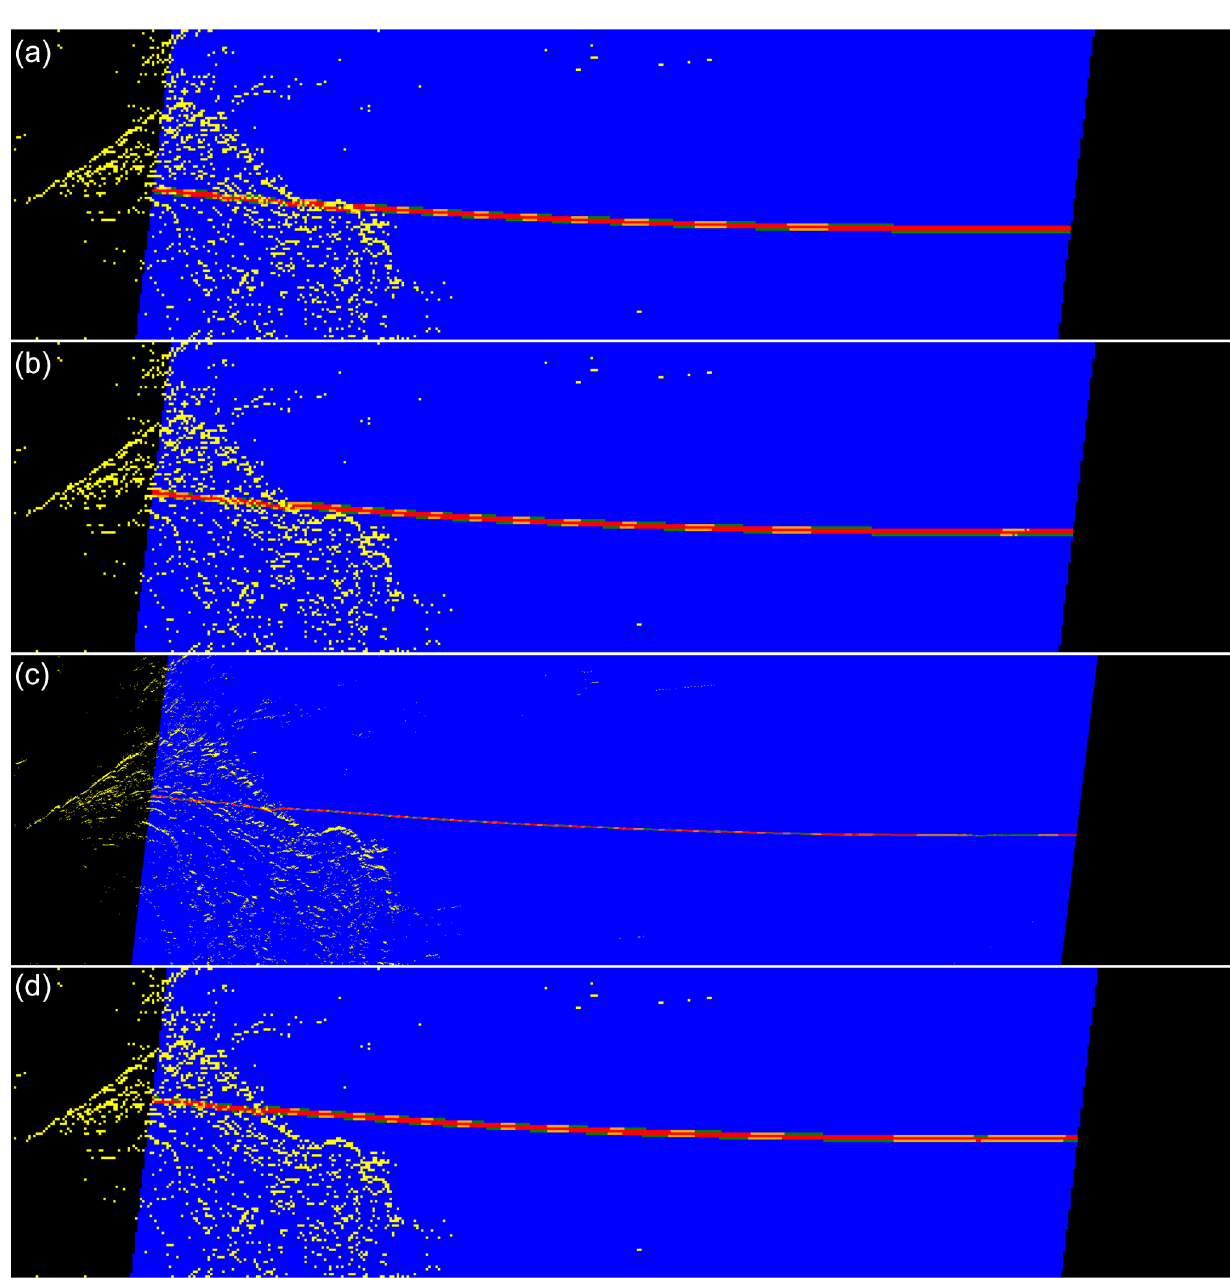
Earth Syst. Sci. Data, 12, 1321–1346, 2020